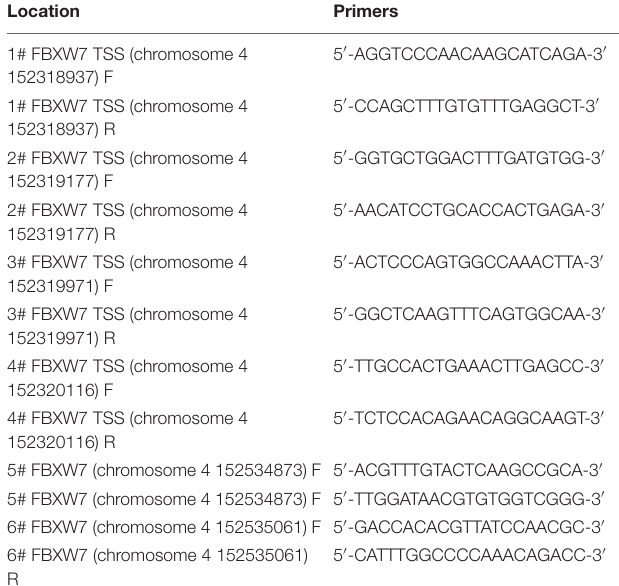
TABLE 1 | The primers used in the ChIP-PCR assays. Location